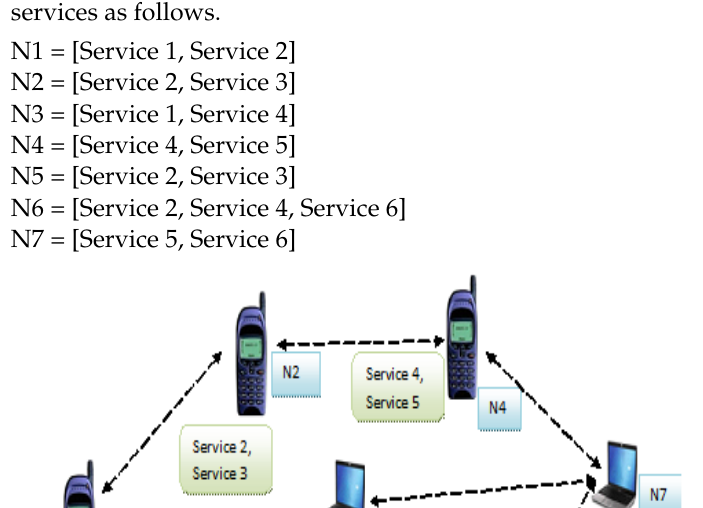
Figure 1. Composite services of mobile nodes.